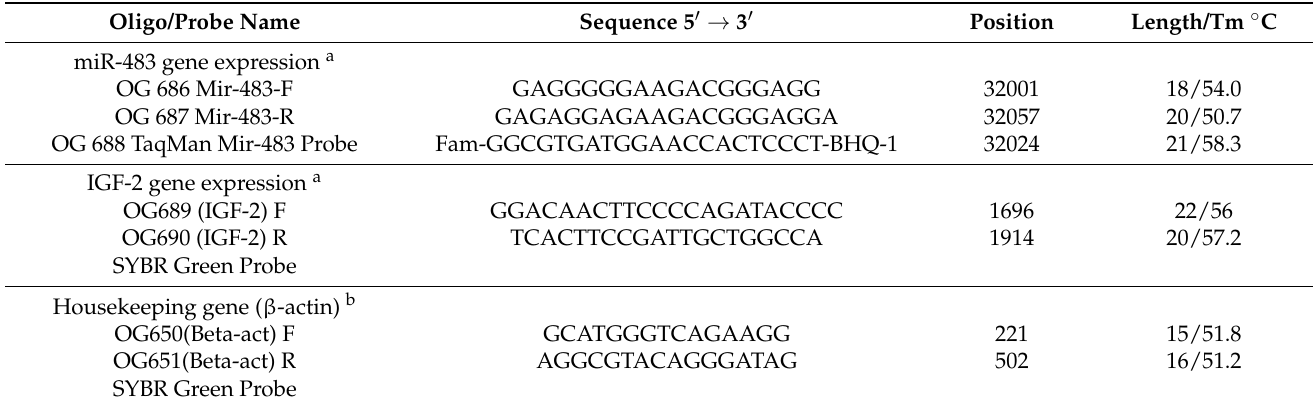
Table 4. Oligonucleotide sequences for primers and probes utilized for gene